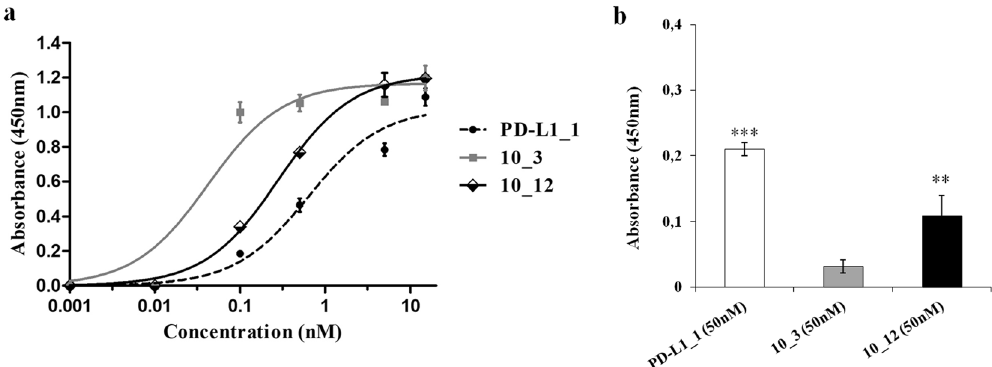
Figure 4. Binding affinity of PD-L1_1 and its variants to human PD-L1 protein and mouse CT26 cancer cells. ( a ) ELISA assay on human PD-L1/Fc protein carried out with 10_3 (grey curve), 10_12 (black curve) or PD- L1_1 (dashed curve). ( b ) Cell ELISA on CT26 colon cancer cells to test the crossreactivity of 10_3 (grey bar) and 10_12 (black bar) mAbs compared to that of the parental PD-L1_1 (white bar). Error bars depicted means ± SD. P values for the indicated mAbs relative to untreated control, are: *** P ≤ 0.001; ** P <